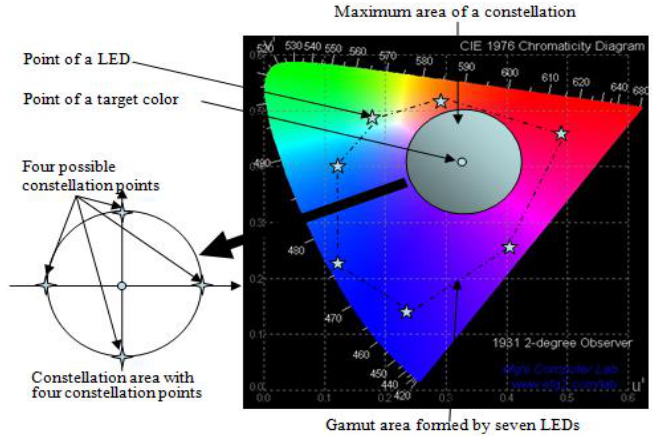
Figure 2. Generation example of a constellation diagram for a target color in CIELUV color space (example uses seven LEDs and two bit data symbols).